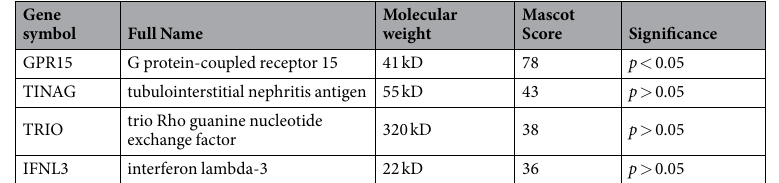
Table 1. Proteins pulled down by TME5 from MALDI-TOF MS analysis.